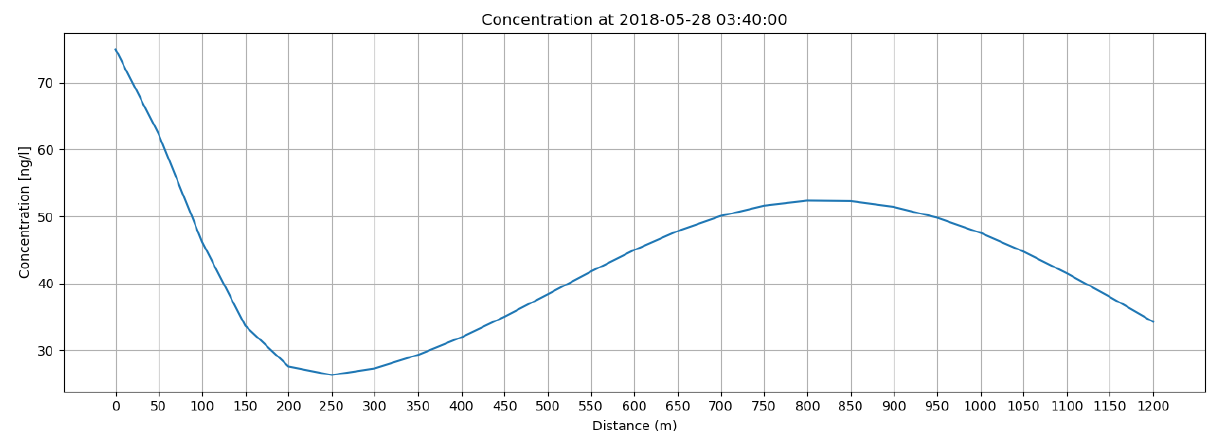
7 of 16 Figure 4. Example graph: solution at a selected point as function of time.